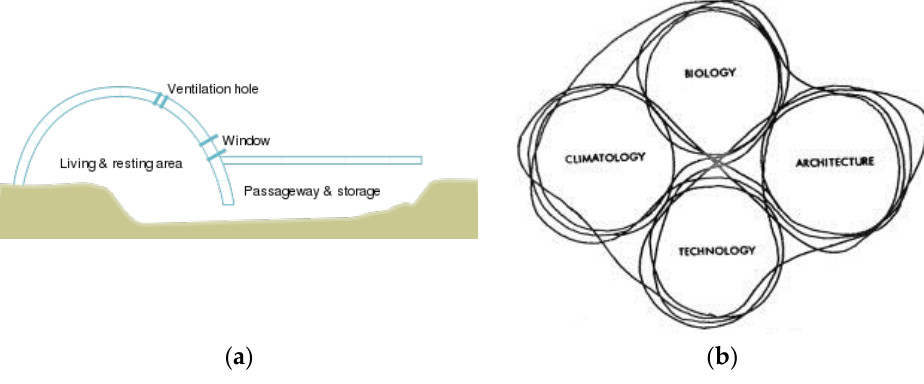
Figure 1. ( a ) Igloo construction, with the compact of snow to insulate the interior where is warmed by body heat alone [17]; ( b ) Interlocking fields: Bioclimatic Design